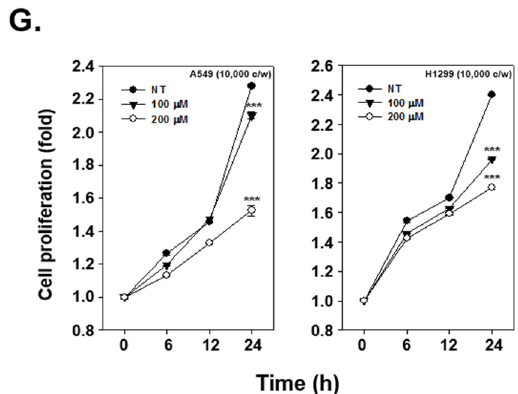
Figure 3. OMT promotes apoptosis in A549 cells and H1299 cells. ( A ) OMT can downregulate levels of anti-apoptotic proteins such as Bcl-2, Bcl-xl, Survivin, IAP-1, IAP-2, COX-2, VEGF, and MMP-9. A549 cells (5 × 10 5 cells/well) were treated with OMT in indicated concentrations for 24 h. Whole cell lysates were prepared with the same amount and analyzed via Western blot analysis. ( B ) A549 cells (5 × 10 5 cells/well) were treated with various concentrations of OMT for 24 h. Total RNA was extracted, and equal amounts were examined for expression of Bcl-2, Bcl-xl, and Survivin by RT-PCR. ( C ) Whole cell lysates were prepared with the same amount, and expression of the proteins was analyzed via Western blot analysis. ( D ) A549 cells (5 × 10 5 cells/well) were treated with OMT (0, 100, 200 µ M) for 24 h. Cells were digested with RNase A for 1 h and stained with propidium iodide, and cell cycle division was analyzed with flow cytometric analysis. The results are presented as the mean ± SE. The experiments were performed three times independently. * p < 0.05 and ** p < 0.01 compared to the control. ( E , F ) A549 cells (5 × 10 5 cells/well) and H1299 cells (5 × 10 5 cells/well) were treated with OMT (200 µ M) for 24 h. After treatment, cells were stained with Annexin V-FITC and then analyzed by flow cytometry. ( G ) OMT inhibited cell growth. A549 cells (1 × 10 4 cells/well) and H1299 cells (1 × 10 4 cells/well) were treated with OMT (0, 100, 200 µ M) for indicated time intervals. Cell viability was analyzed by MTT assay. The results are presented as the mean ± SE. The experiments were performed three times independently. *** p < 0.001 compared to the control.